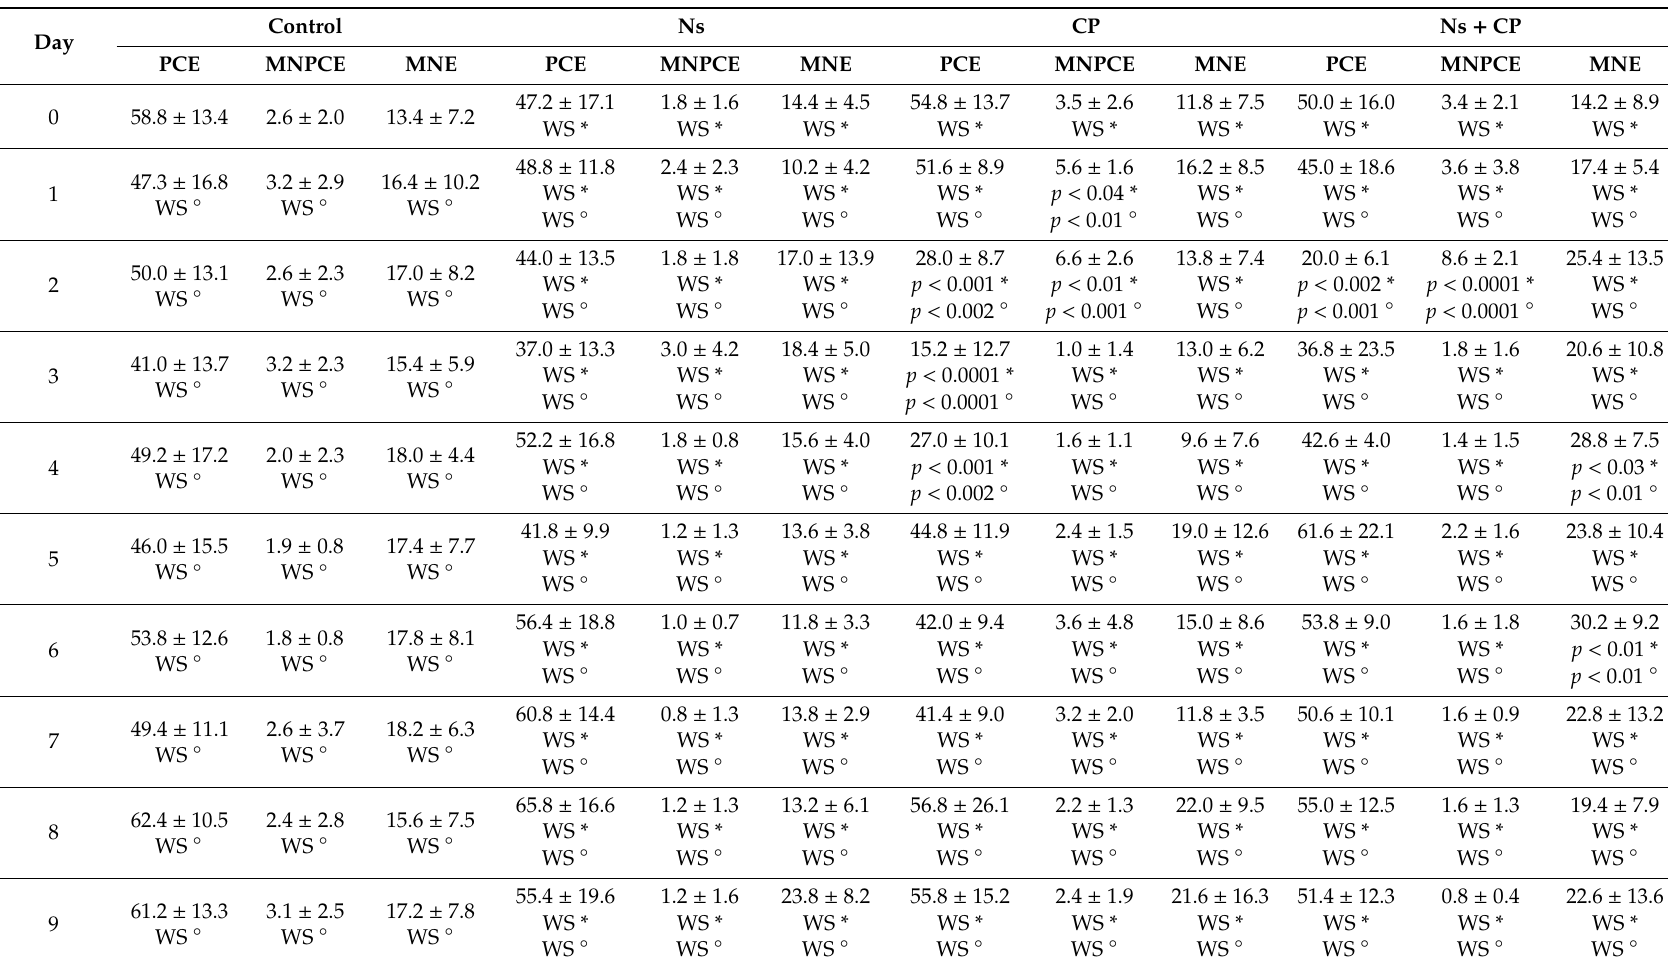
Table 1. PCE, MNPCE, MNE, and frequencies from mice study